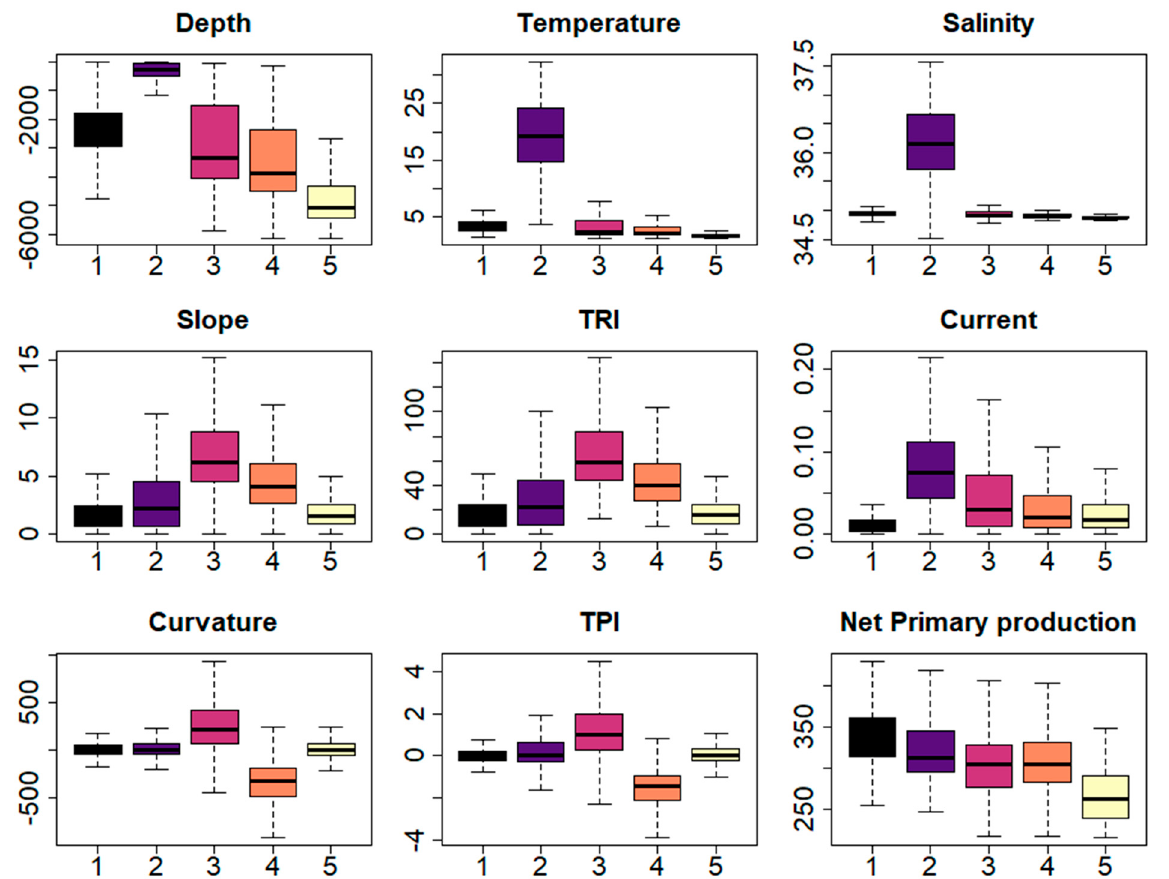
Figure 6. Boxplots of the nine original abiotic variables for each of the K-means derived clusters for the larger study area using four eigenvalues. The x-axis denotes the five K-means clusters, the y-axis denotes the respective units of each abiotic variable. The colours represent the corresponding cluster in the landscape map (Figure 5). Format of boxplots as described in Figure 4.